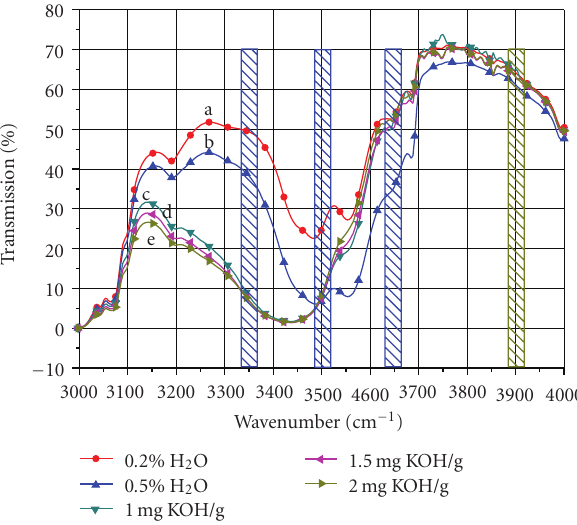
Figure 3: IR transmission of water-contaminated and heat-treated Skydrol LD4, a, b after addition of increasing amounts of water, c, d, e after additional heat treatment leading to acidification. Optical path length: 0.2